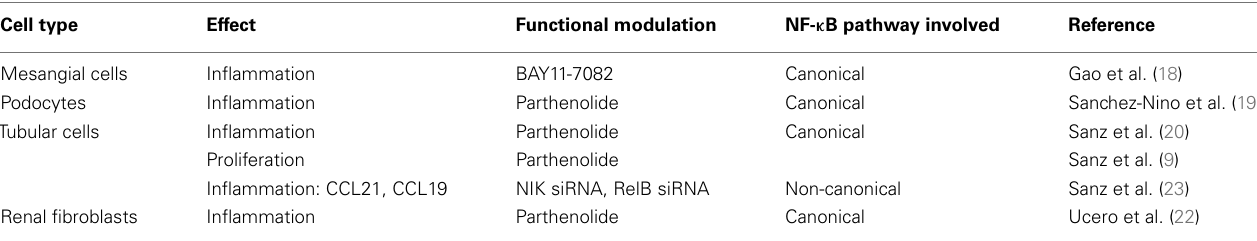
Table 1 |TWEAK actions on kidney cells involving NF- κ B activation and evidence for the role of canonical or non-canonical pathways. Cell